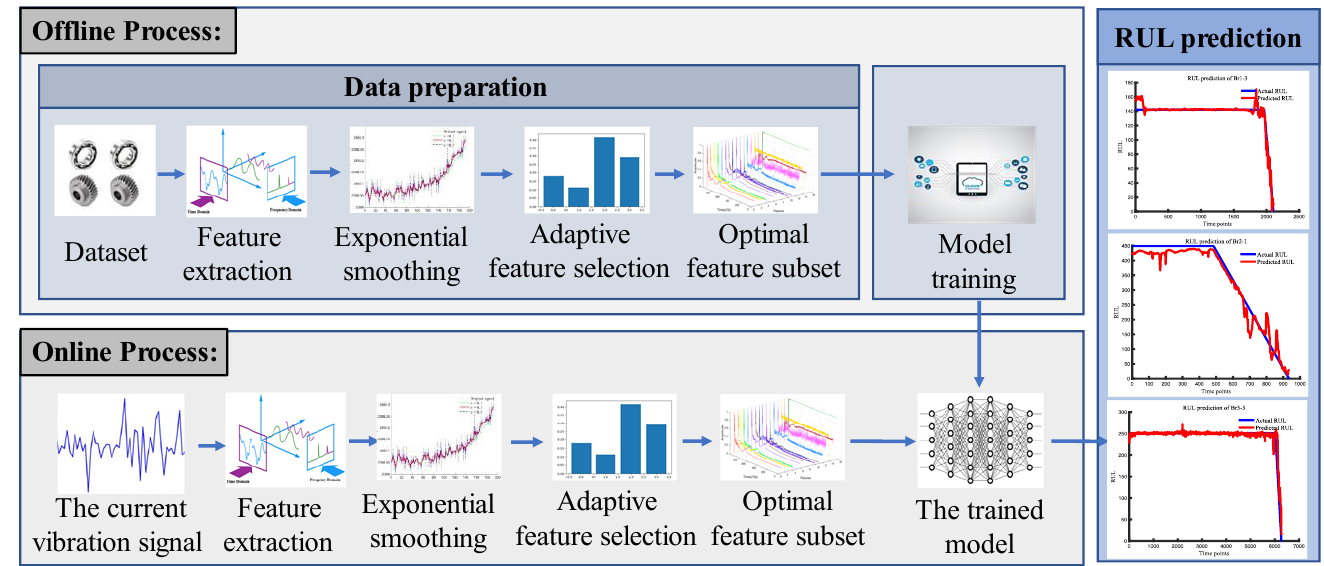
model construction.